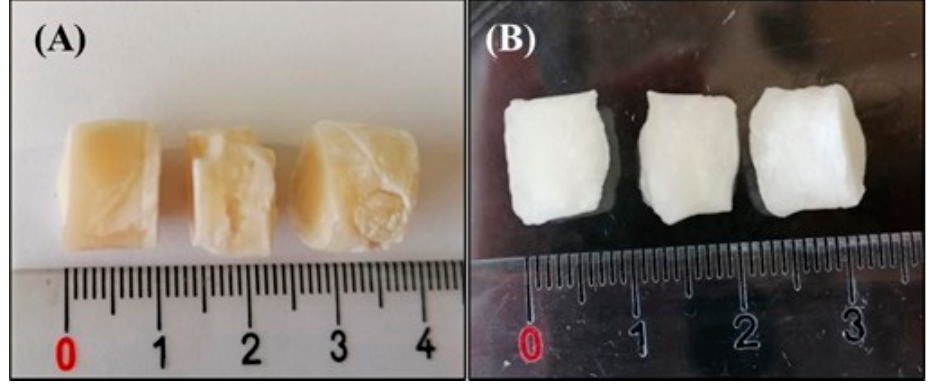
Figure 5. Macroscopic appearance of ( A ) freeze-dried and ( B ) swollen CGC hydrogel samples.